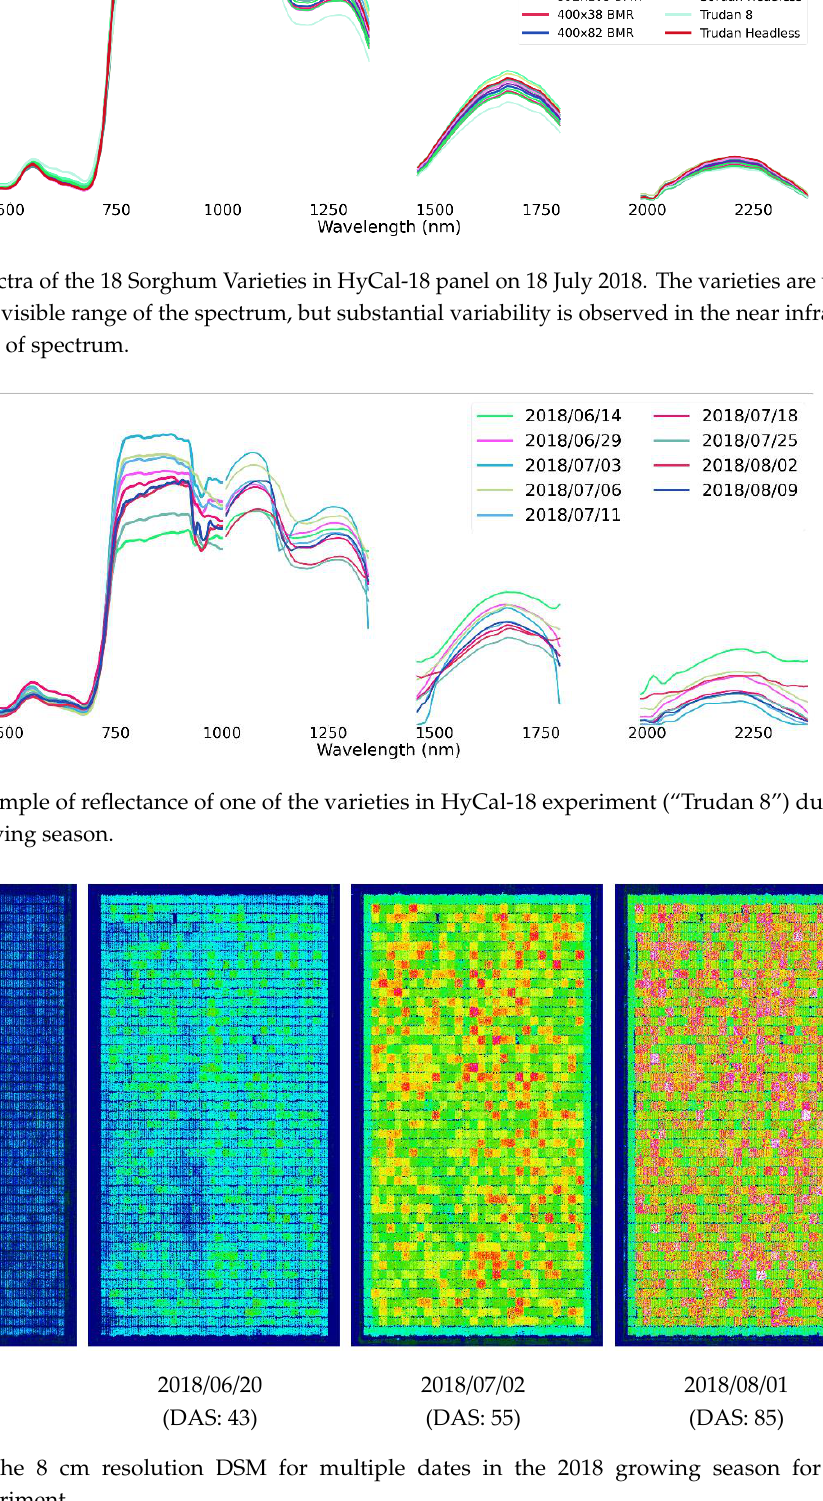
Figure 7. The 8 cm resolution DSM for multiple dates in the 2018 growing season for the SbDivTc experiment.